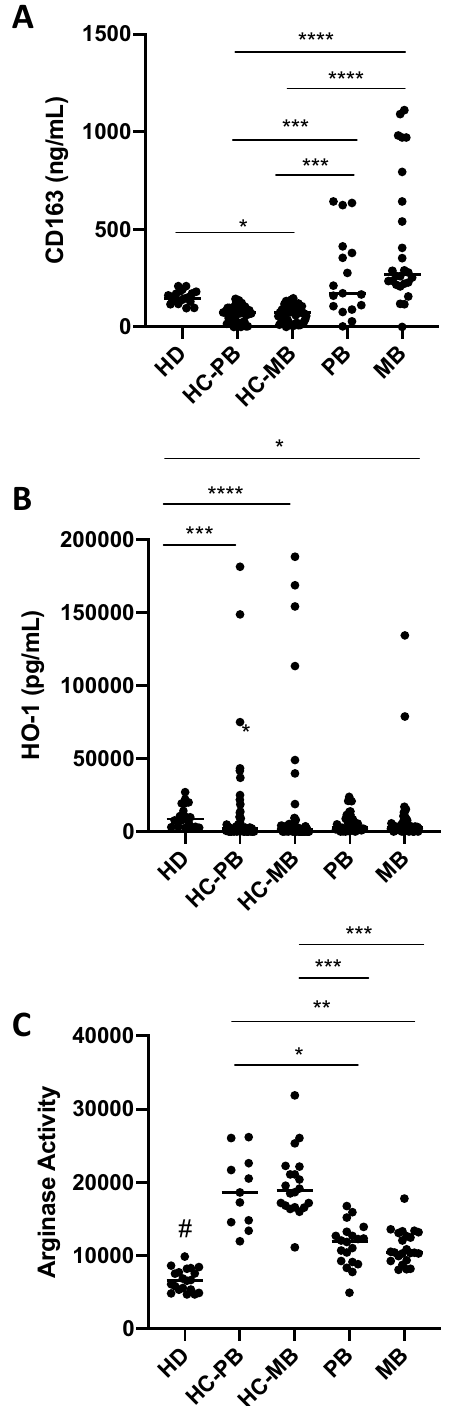
Figure 1. Contacts of leprosy patients present higher arginase activity than healthy controls and patients. Serum from healthy donors of endemic areas (HD, n = 18), paucibacillary patients (PB, n = 42), multibacillary patients (MB, n = 59), household contacts of PB patients (HC-PB, n = 58), and household contacts of MB patients (HC-MB, n = 83) were collected and levels of soluble ( A ) CD163 and ( B ) HO-1 were evaluated by ELISA. In addition, ( C ) arginase activity was evaluated. * p ≤ 0.05, ** p ≤ 0.01, *** p ≤ 0.001, **** p ≤